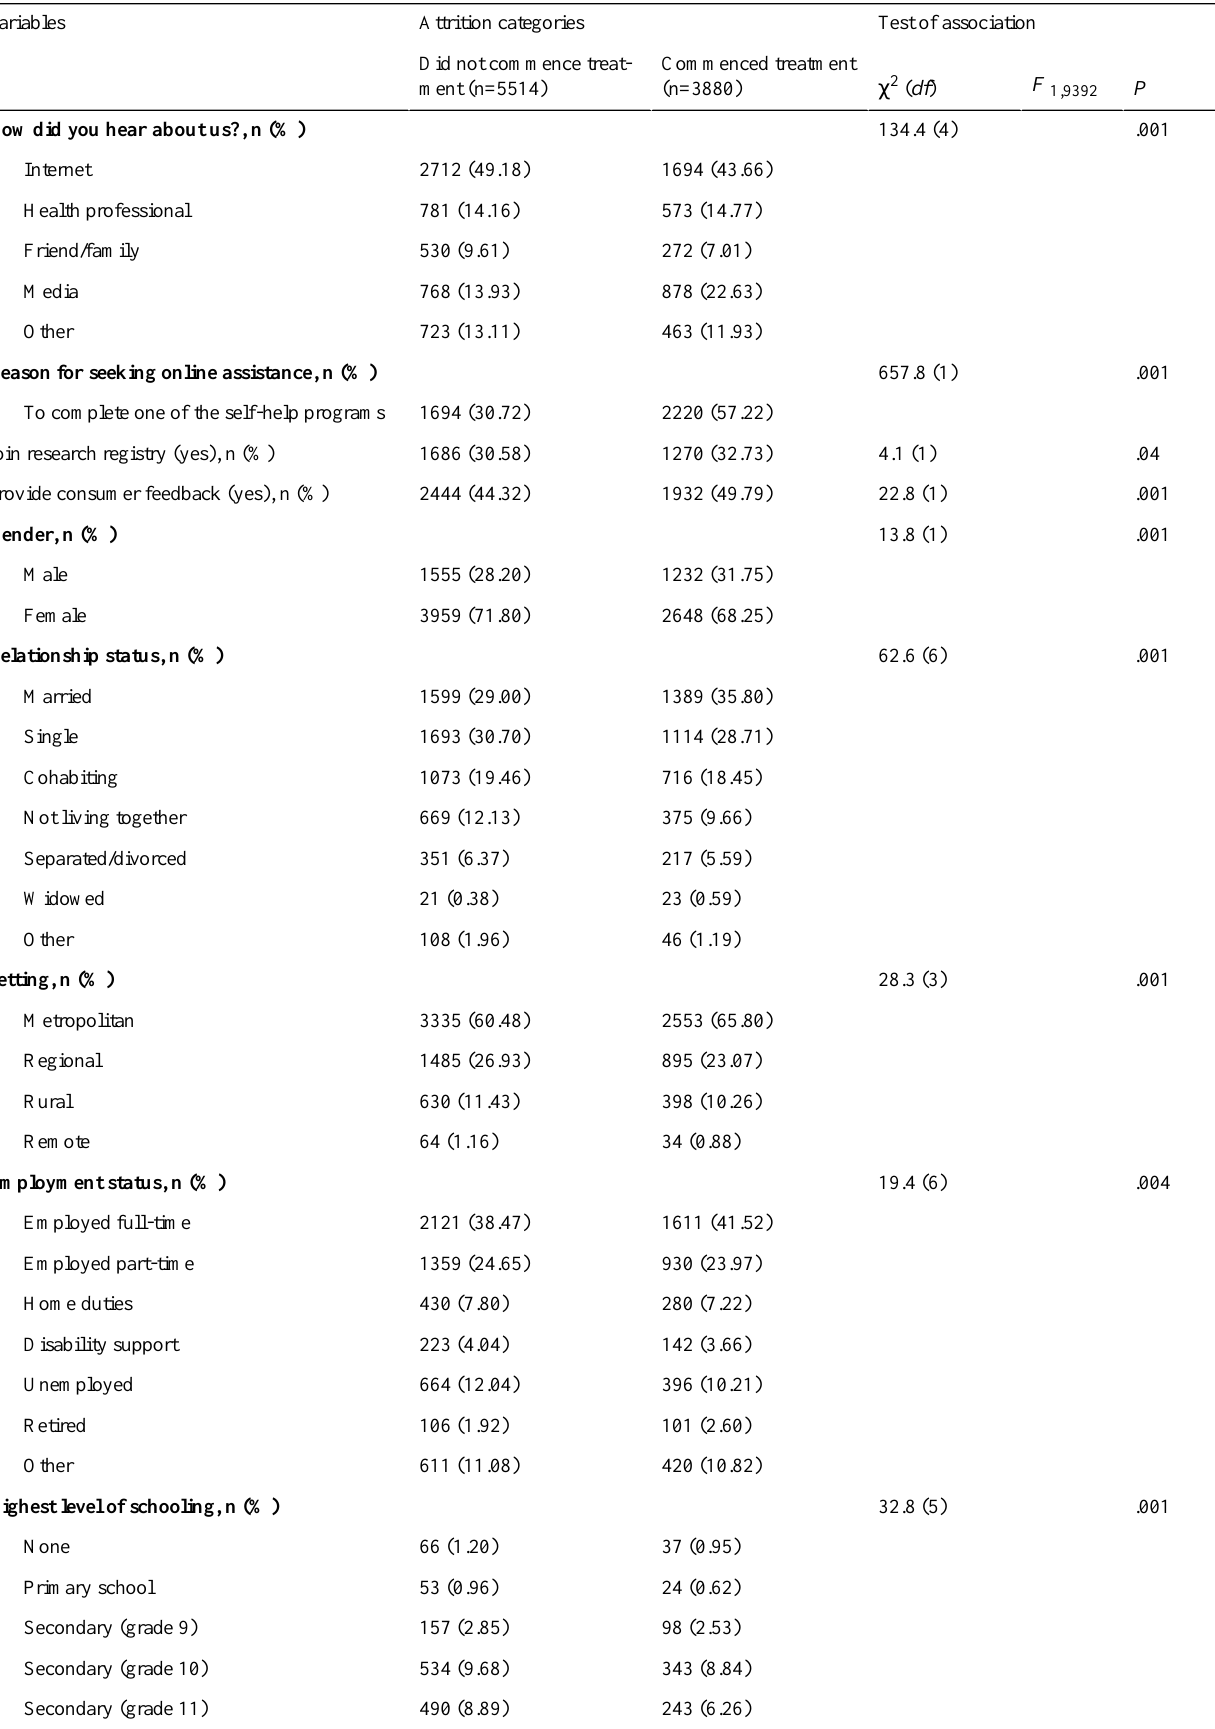
Table 1. Predictor analysis for attrition categories for those who commenced treatment vs those who did not commence treatment (N=9394).